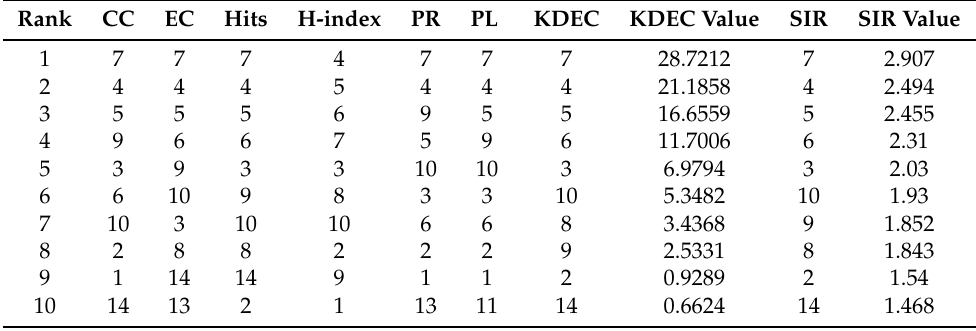
Table 4. Ranking results in toy network by KDEC and other comparison